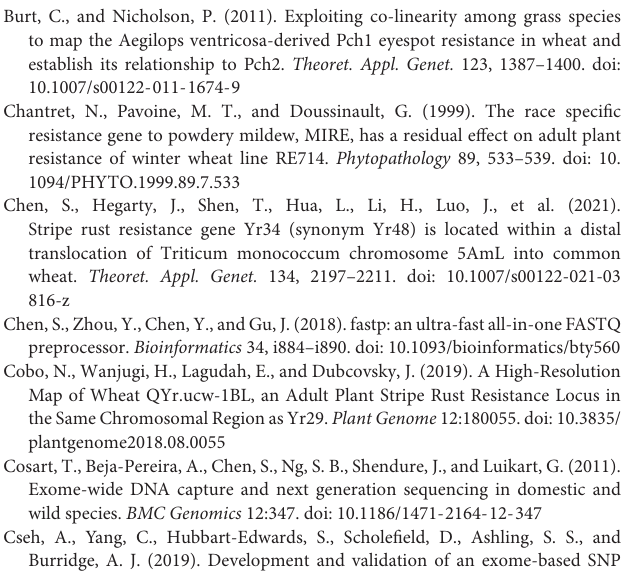
Supplementary Figure 1 | Sequence coverage diagrams for chromosome 2B of the accession ‘Riband’ using different alignment parameters. (A) Average depth of coverage across 5 Mb bins using any good hit to the 2B reference. (B) Average depth of coverage across 5 Mb bins using only sequences that give a unique hit